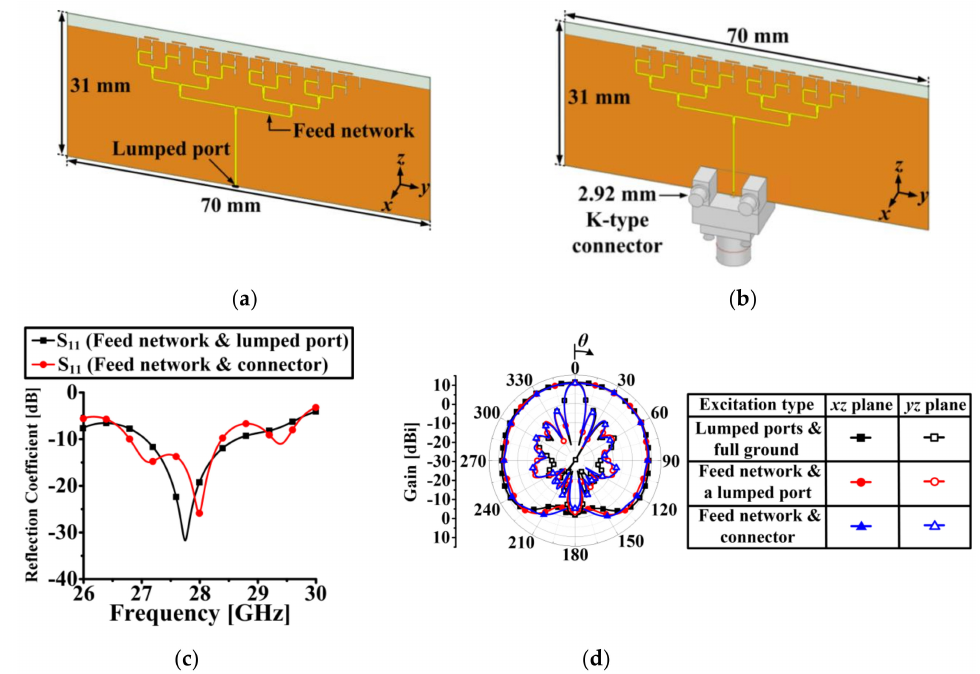
Figure 16. Performance comparison for di ff erent excitation types: ( a ) modified structure with a lumped port, ( b ) modified structure with a connector, ( c ) simulated reflection coe ffi cients, and ( d ) simulated radiation patterns at 28 GHz.